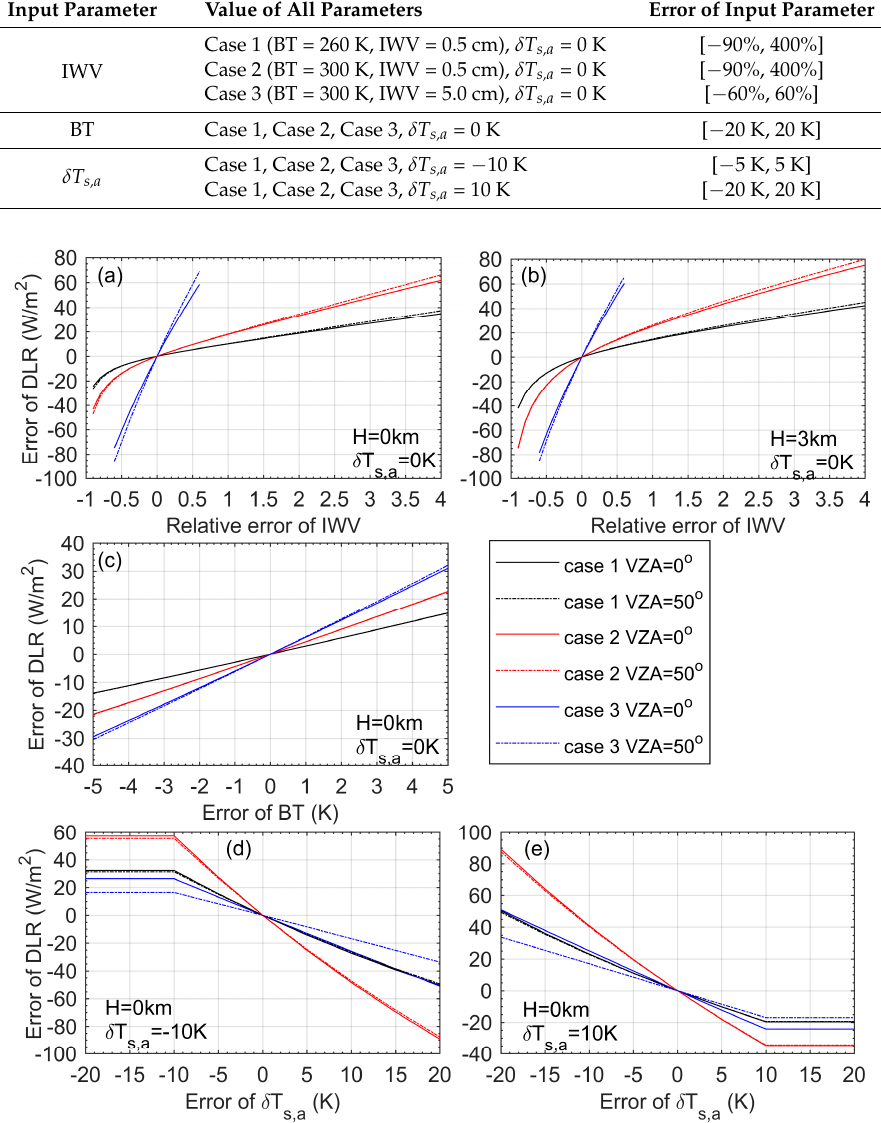
Figure 8. DLR error versus the error of input parameters such as IWV ( a - b ), brightness temperature ( c ), and δ T s,a ( d -e) under different climate conditions. Cases 1, 2, and 3 represent the conditions of BT=260K and IWV=0.5cm, BT=300K and IWV=0.5cm, and BT=300K and IWV=5.0cm,